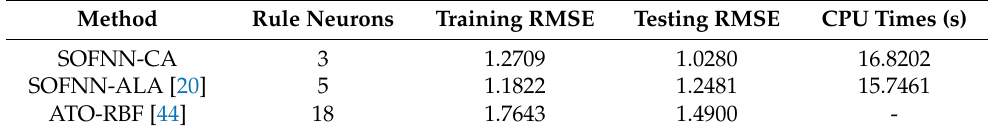
Table 4. Comparison of different methods in benzene-content